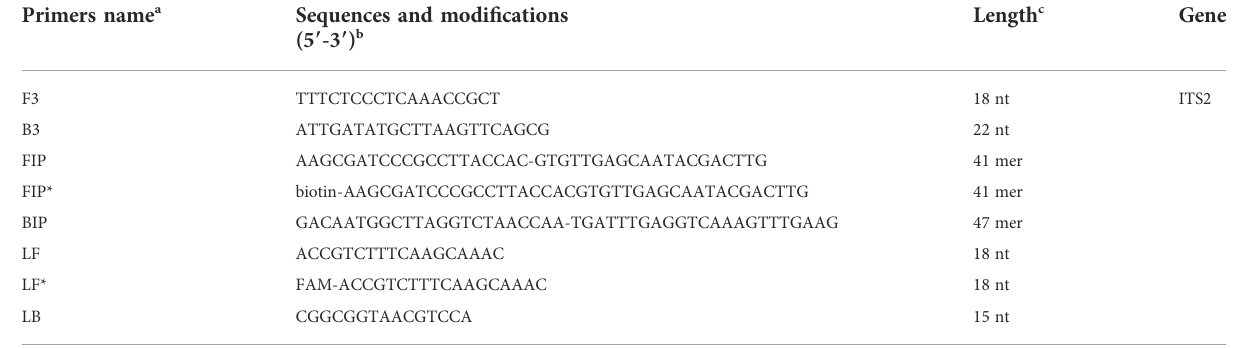
TABLE1 Primers used in this